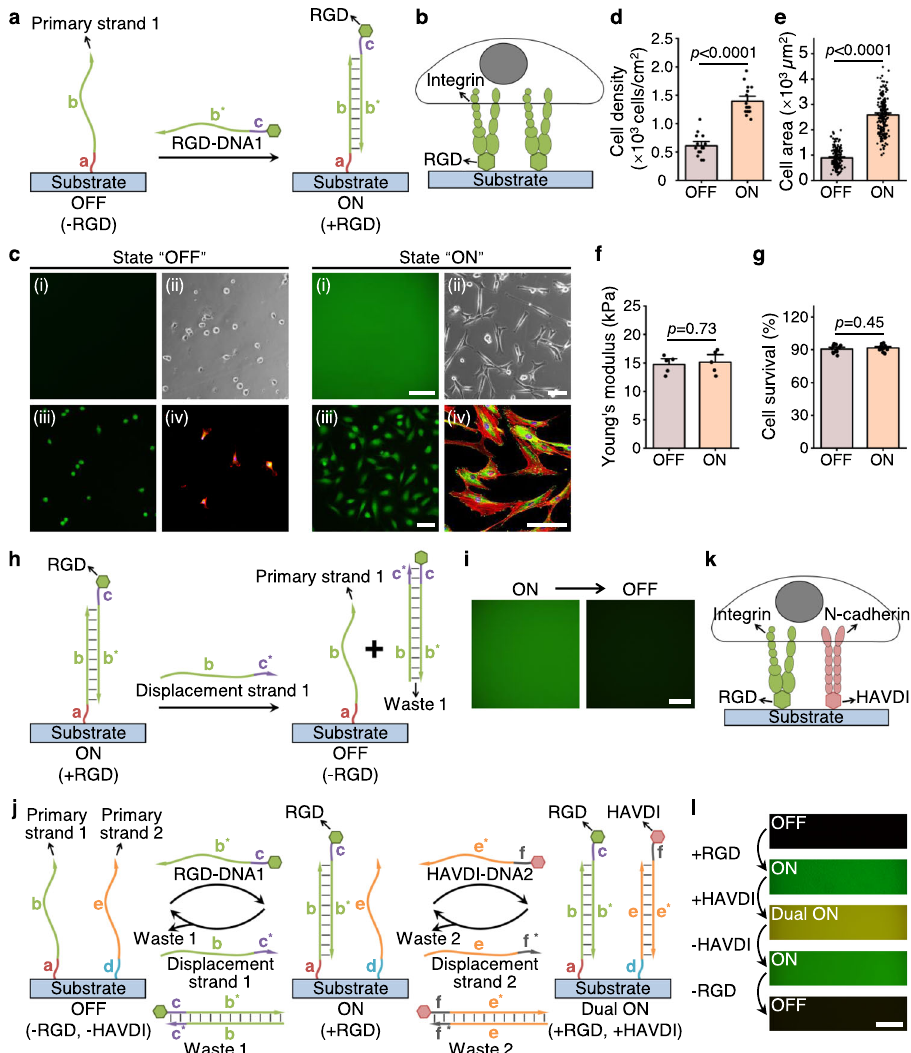
Fig. 1 | Programmable presentation of integrin and N-cadherin adhesive domains to study hMSCs mechanosensing. a Schematic of RGD conjugation to PEGhydrogels byDNA hybridization.DNA strands weredrawnas lineswitharrows at the 3 ′ end. “ * ” indicates complementary sequences. b “ ON ” substrate allows for integrin-RGD adhesive interactions. c Characterization of RGD conjugation and hMSCsadhesionon “ OFF ” and “ ON ” substrates,asshownby(i) fl uorescenceimages of FAM-labeled RGD (this experiment was repeated independently 3 times with similar results), (ii) bright- fi eld, (iii) live-dead staining (green for live cells and red fordeadcells)and(iv)immunostainingforpaxillin(green),F-actin(red),andnuclei (blue). d Cell density (from left to right n = 15, 17 samples) and e spreading area of hMSCs(fromlefttoright n =163,194cells)on “ ON ” and “ OFF ” substrates. f Young ’ s moduliof “ ON ” and “ OFF ” substrates( n = 5samplespergroup). g Quanti fi cationof hMSCsviabilityon “ ON ” and “ OFF ” substrates(fromlefttoright n =11,13samples). h Schematic of RGD removal from “ ON ” hydrogels using a fully